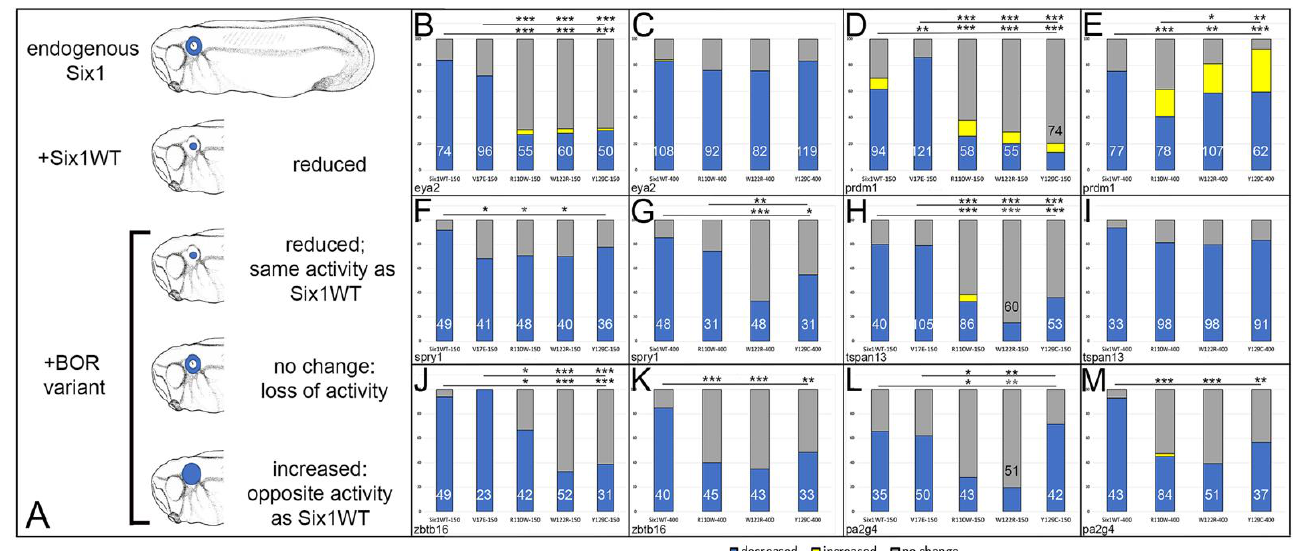
Figure 4. Otic gene expression is altered by Six1 mutants as assessed by ISH. ( A ): Transcripts encoding wild-type Six1 (Six1WT) or BOR variants were microinjected into blastomeres that contribute to otic structures on one side of embryos containing endogenous levels of Six1. The effects on otic vesicle gene expression (blue) were compared between embryos injected with Six1WT (+Six1WT) versus those injected with a BOR variant (+BOR variant). Since Six1WT reduced each otic target gene, if the BOR variant also reduced it at the same frequency, then the variant has the same activity as SixWT. If the BOR variant caused no change in expression, then it has lost activity. If the BOR variant increased expression, then it has the opposite activity of SixWT. ( B ). Percentages of embryos in which eya2 otic expression was decreased (blue), increased (yellow) or not changed (grey) after microinjection of 150 pg of Six1WT, V17E, R110W, W122R or Y129C mRNAs. Numbers inside bars denote number of embryos analyzed. Lower line and asterisks indicate comparison of Six1WT frequencies to those of each mutant. Upper line and asterisks indicate comparison of V17E frequencies to those of the other three mutants. * p < 0.01; **, p < 0.001; ***, p < 0.0001 comparison by chi-square test. ( C ). Percentages of embryos in which eya2 otic expression was altered after microinjection of 400 pg of Six1WT, R110W, W122R or Y129C mRNAs. There were no significant differences between the different groups. Labeling as in ( B ). ( D ). Percentages of embryos in which prdm1 otic expression was altered after microinjection of 150 pg of Six1WT, V17E, R110W, W122R or Y129C mRNAs. Labeling as in ( B ). ( E ). Percentages of embryos in which prdm1 otic expression was altered after microinjection of 400 pg of Six1WT, R110W, W122R or Y129C mRNAs. Labeling as in ( B ). ( F ). Percentages of embryos in which spry1 otic expression was altered after microinjection of 150 pg of Six1WT, V17E, R110W, W122R or Y129C mRNAs. Labeling as in ( B ). ( G ). Percentages of embryos in which spry1 otic expression was altered after microinjection of 400 pg of Six1WT, R110W, W122R or Y129C mRNAs. Labeling as in ( B ). ( H ). Percentages of embryos in which tspan13 otic expression was altered after microinjection of 150 pg of Six1WT, V17E, R110W, W122R or Y129C mRNAs. Labeling as in ( B ). ( I ). Percentages of embryos in which tspan13 otic expression was altered after microinjection of 400 pg of Six1WT, R110W, W122R or Y129C mRNAs. There were no significant differences between the different groups. Labeling as in ( B ). ( J ). Percentages of embryos in which zbtb16 otic expression was altered after microinjection of 150 pg of Six1WT, V17E, R110W, W122R or Y129C mRNAs. Labeling as in ( B ). ( K ). Percentages of embryos in which zbtb16 otic expression was altered after microinjection of 400 pg of Six1WT, R110W, W122R or Y129C mRNAs. Labeling as in ( B ). ( L ). Percentages of embryos in which pa2g4 otic expression was altered after microinjection of 150 pg of Six1WT, V17E, R110W, W122R or Y129C mRNAs. Labeling as in ( B ). ( M ). Percentages of embryos in which pa2g4 otic expression was altered after microinjection of 400 pg of Six1WT, R110W, W122R or Y129C mRNAs. Labeling as in ( B